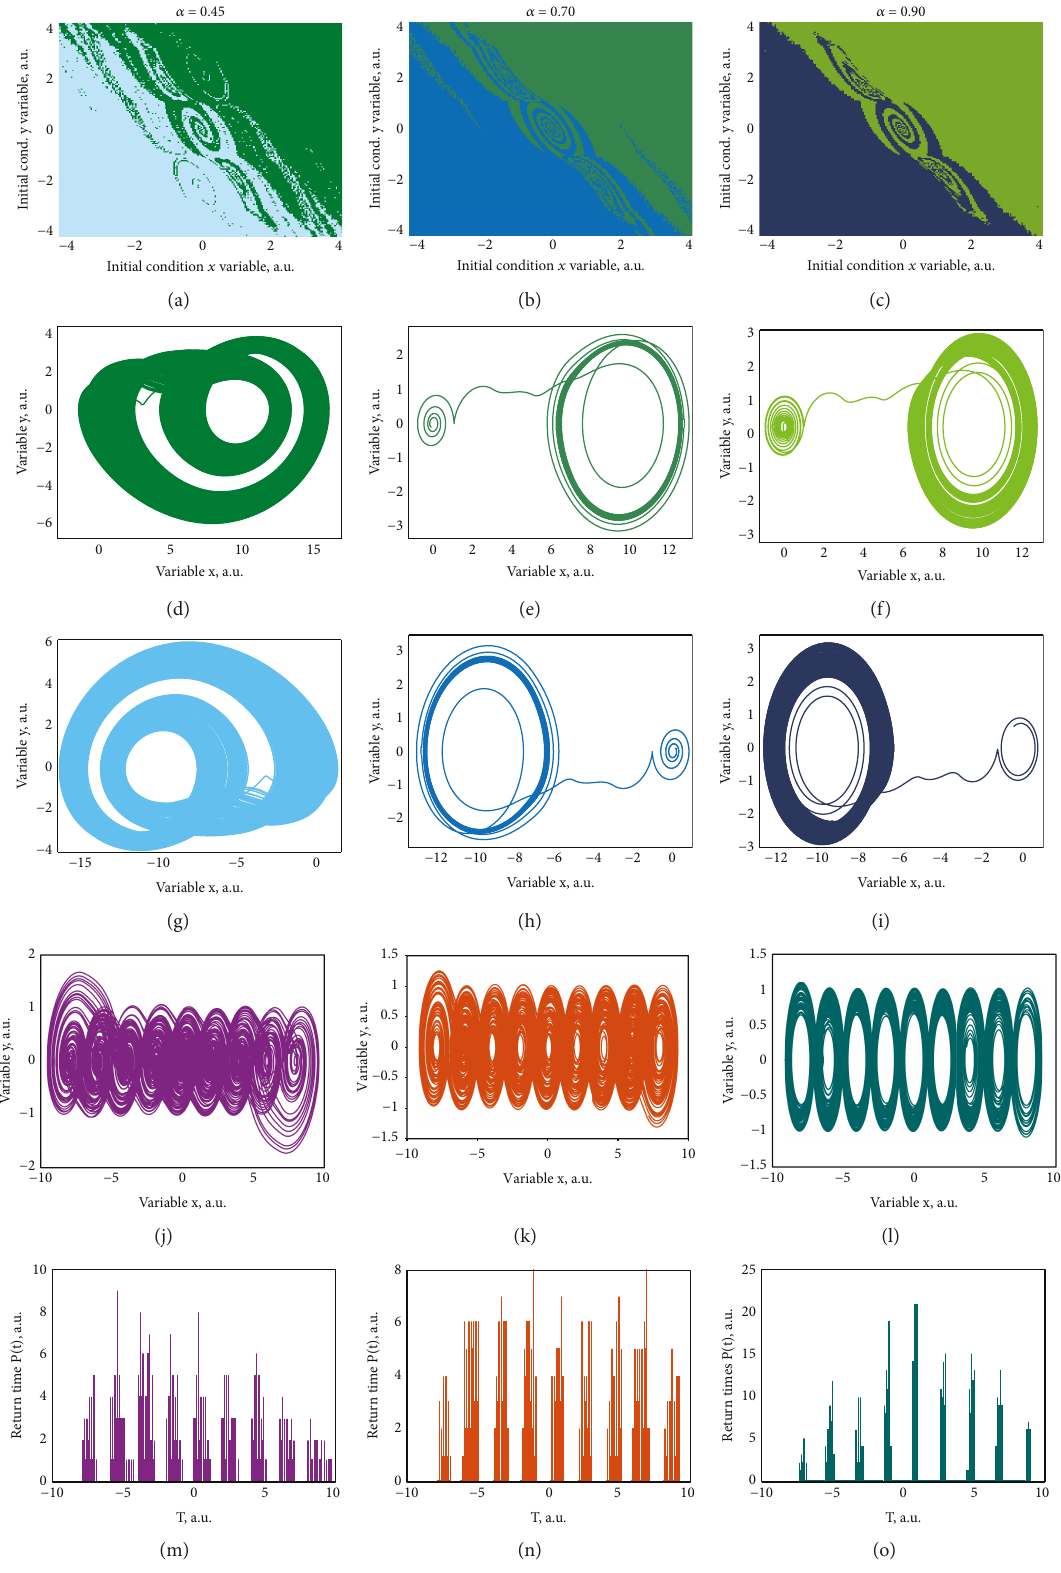
Figure 8: (a – c) Basins of attraction for the coexisting coherent single-wing attractor. (d – i) Coexisting attractors for each basin of attraction. (j – l) Natural system attractor. (m – o) Return time distribution calculated by the Poincare section for the natural system attractor. Columns from left to right correspond to α = 0 45 , 0 70 , 0 90